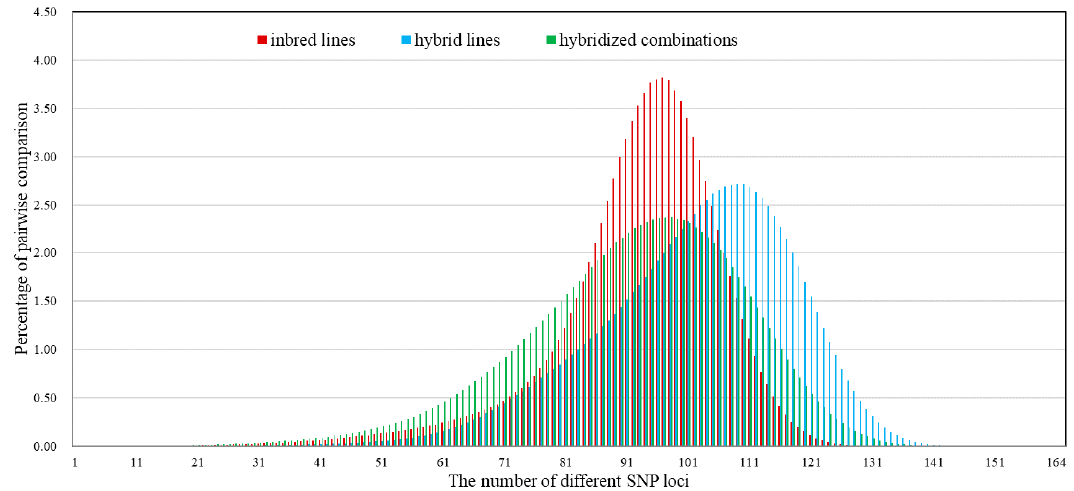
Figure 5. The distribution of the number of different SNPs obtained by pairwise analysis of maize hybrid lines, hybridized combinations and inbred lines respectively.